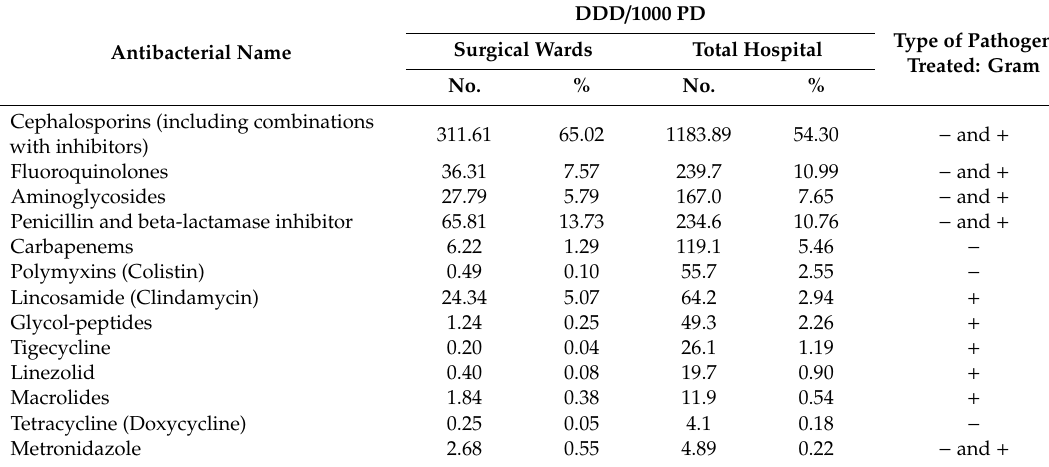
Table 1. Antibiotics prescribed by classes.